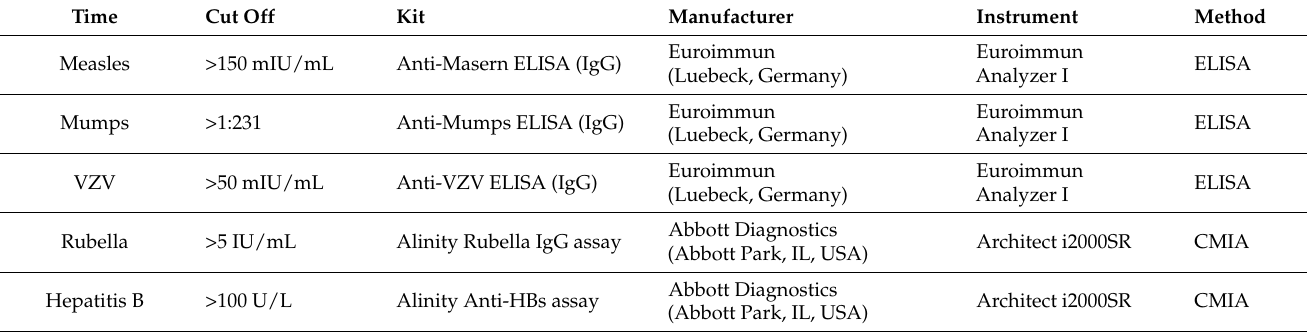
Table A1. Instruments, cut-off values and methods used on peripheral venous blood